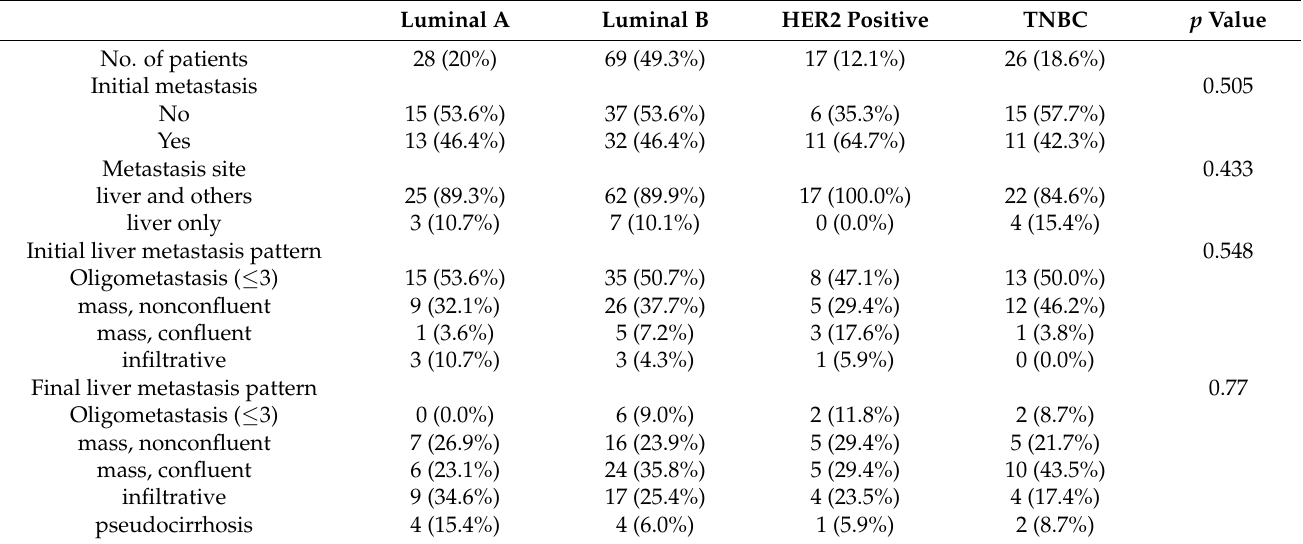
Table 2. Association between molecular subtype and liver metastasis